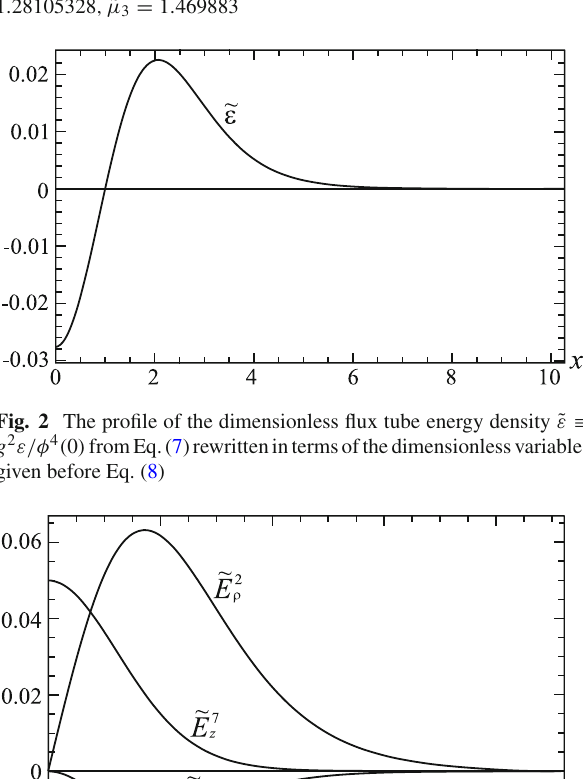
Fig. 1 The graphs of the Proca field potentials ˜ h ≡ gA 2 t /φ( 0 ) , ˜ v ≡ gA 5 z /φ( 0 ) , ˜ w ≡ gA 7 ϕ / x and of the scalar field ˜ φ for the following values of the system parameters: ˜ λ = 2 , ˜ (cid:6) = 0 . 1 , ˜ h 0 = 0 . 2 , ˜ v 0 = 1 . 28105328 , ˜ μ 3 = 1 . 469883